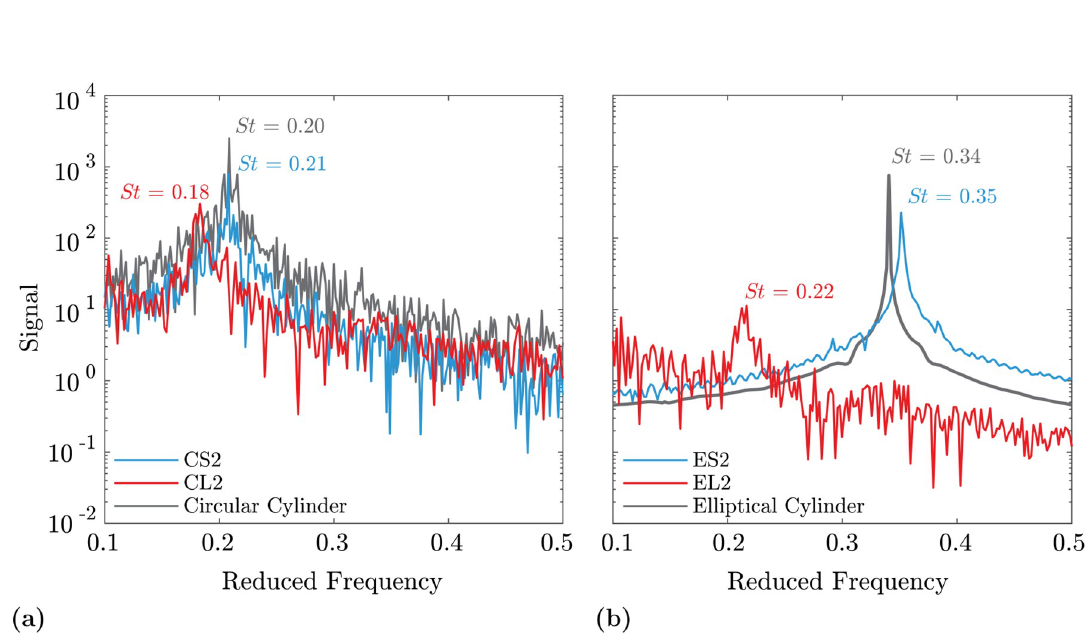
Fig 14. Frequency spectra for low and high λ geometries. The frequency spectra for low and high values of λ and γ are compared with the smooth cylinder cases showing St similarity between low λ and smooth models. (a) Circular aspect ratio. (b) Elliptical aspect ratio.